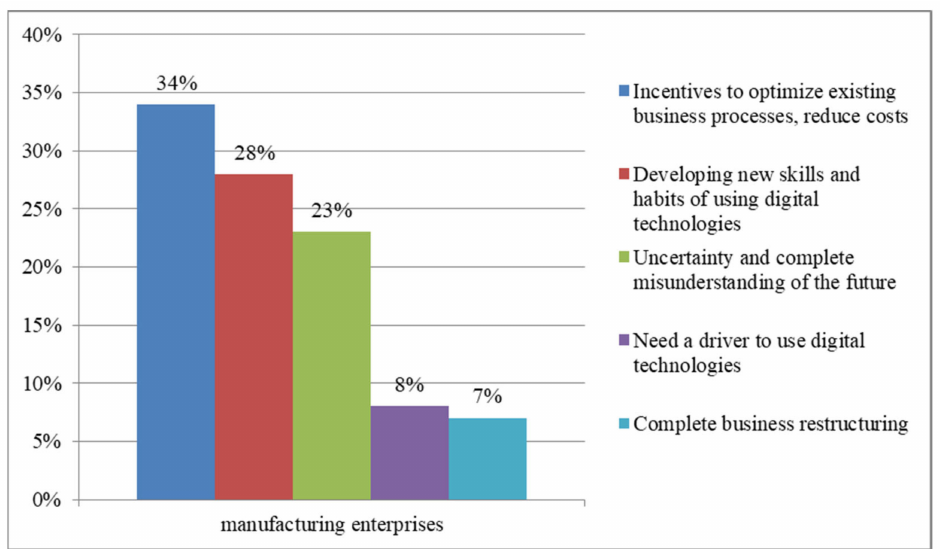
Figure 13. Opinions of enterprises of the respondents from the manufacturing sector of the Republic of Mordovia about their readiness to use digital technologies in